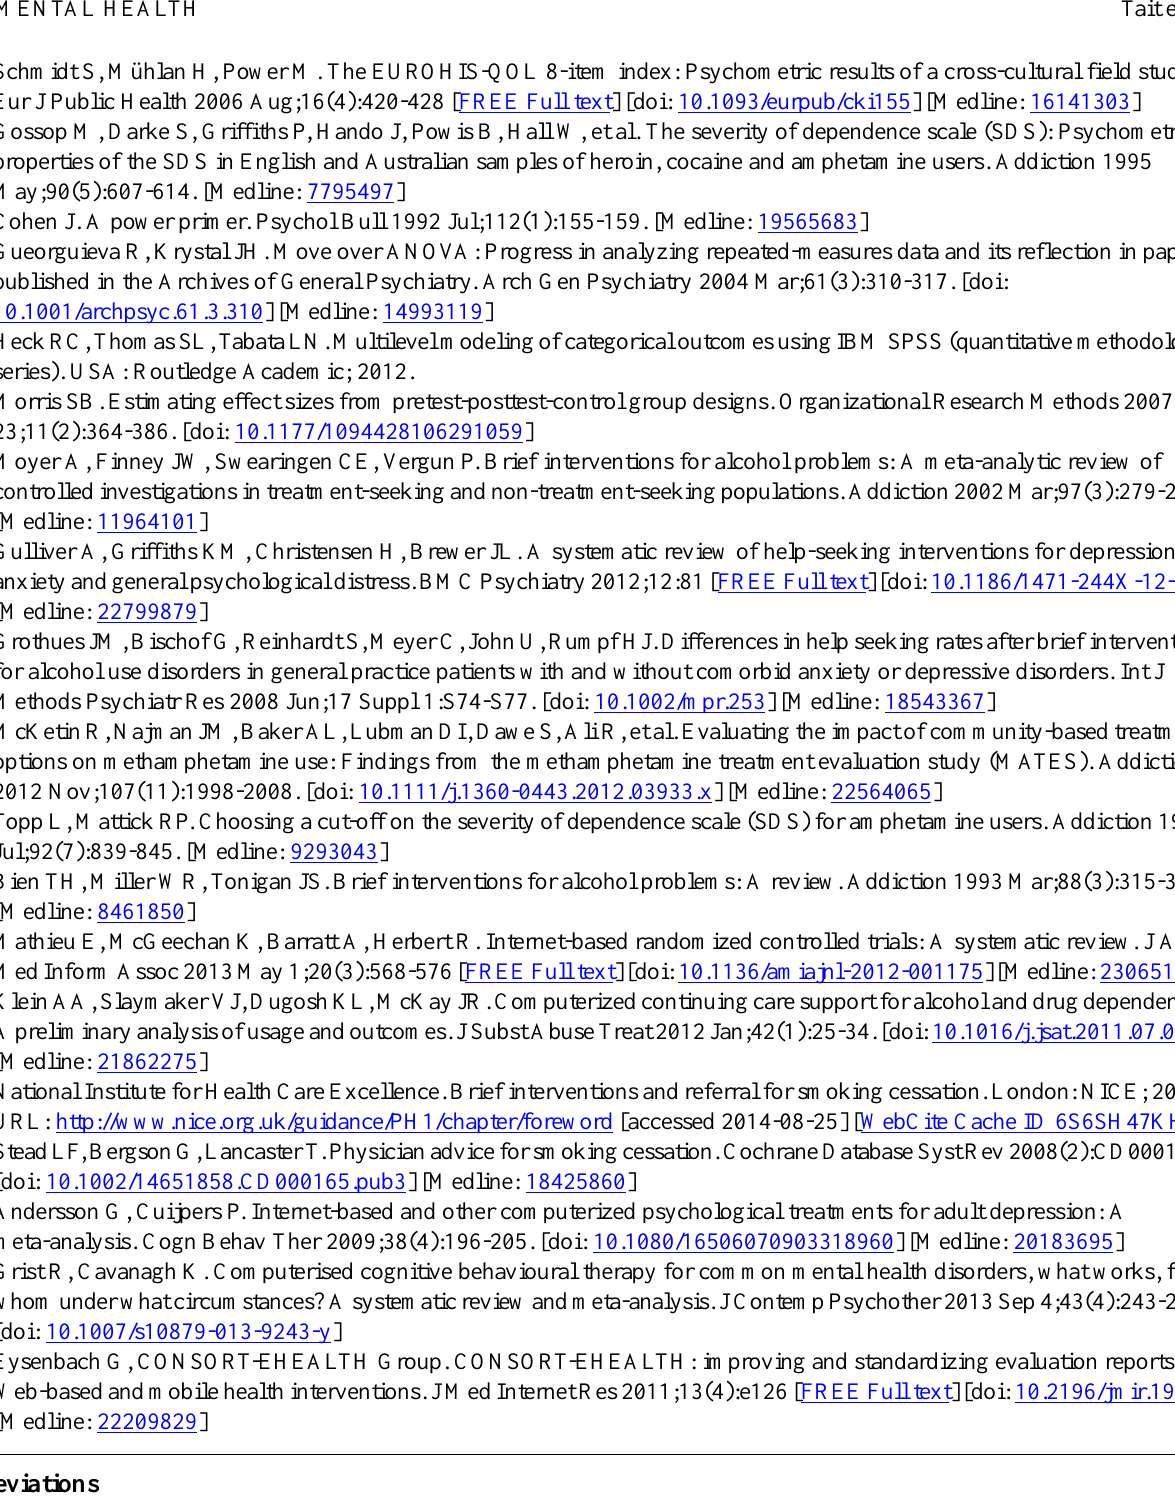
AHSQ: actual help-seeking questionnaire ASSIST: Alcohol, Smoking, Substance Involvement Screening Test ATS: amphetamine-type stimulants